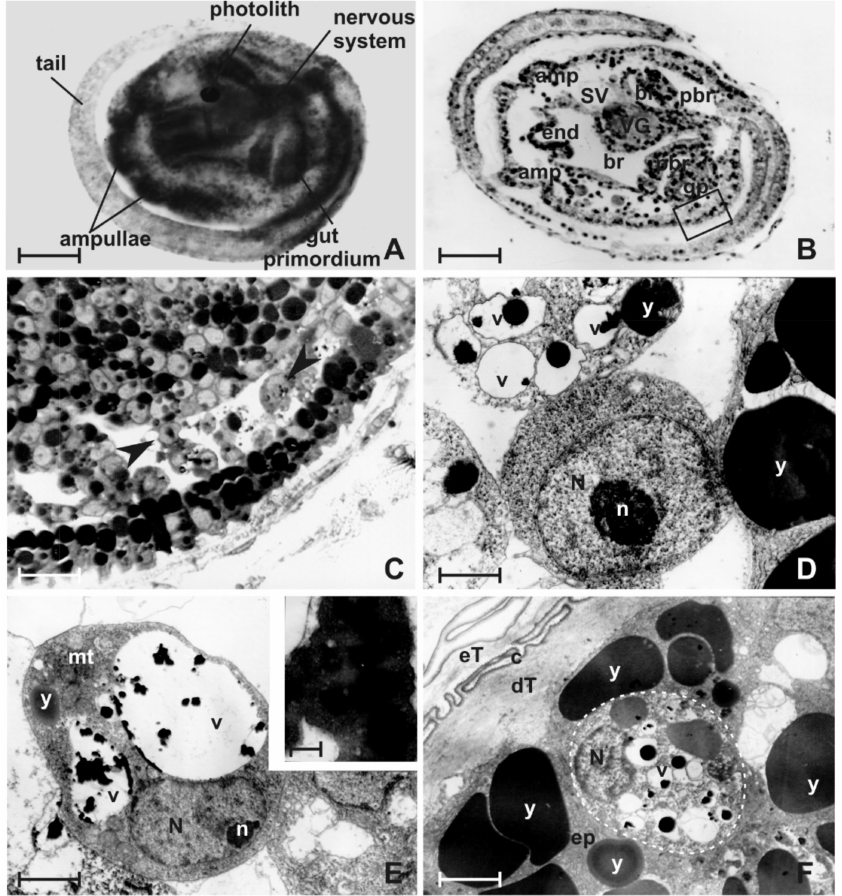
Figure 3. Late tailbud embryos: ( A ) embryo collected from a parental zooid of the colony and viewed in toto; ( B ) longitudinal thick section of an embryo showing both larval and adult organ primordia; ( C ) detail of ( B ) showing various types of haemocytes ( arrowheads ) in the haemocoel; ( D ) haemoblast ( in the centre ) and morula cell ( on the top ); ( E ) morula cell with a few vacuoles containing electron-dense aggregates occasionally clustered and merged ( inset ); and ( F ) morula cell ( dotted circle ) migrating from the haemocoel across the epidermis towards the definitive tu- nic, which can be distinguished from the embryonic tunic above for the presence of an